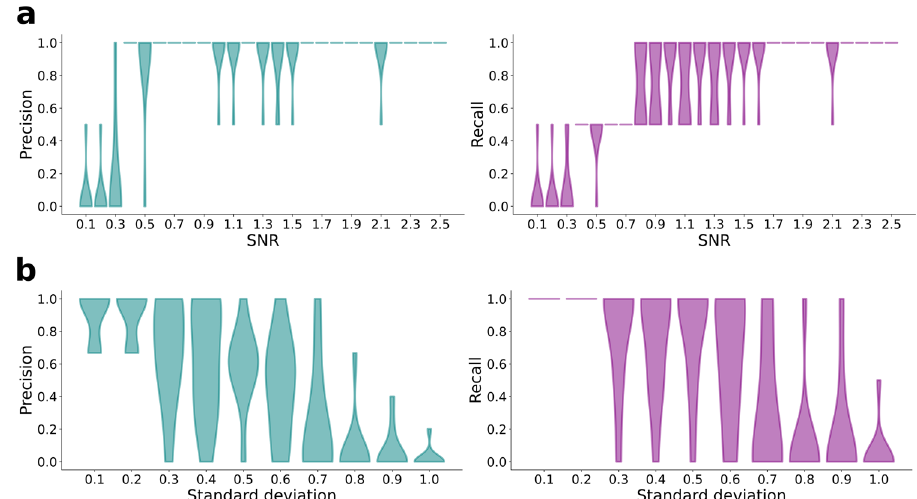
Fig. 3 Analysis of robustness of MAP estimation of epileptogenic zone. a Accuracy of the estimated EZ as the signal-to-noise ratio is increased from 0.1 to 2.5. For each SNR, n = 50 independent data sets are generated and EZ is estimated using MAP. b Accuracy of estimated EZ with MAP initialized at different values of parameters. Initial conditions are generated using a proposal distribution, which is de fi ned such that it has the same mean as the priors of the parameters but with SD ranging from 0.1 to 1.0. At each SD, n = 50 independent samples are generated and used as initial conditions for MAP. EZ, epileptogenic zone; MAP, maximum a posteriori; SNR, signal-to-noise ratio.